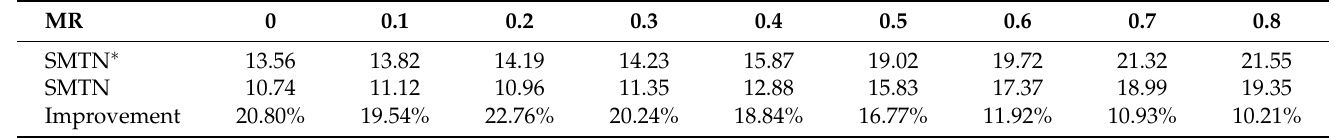
Table 2. The performance comparison of SMTN ∗ and SMTN on FD003 using RMSE under different missing rates